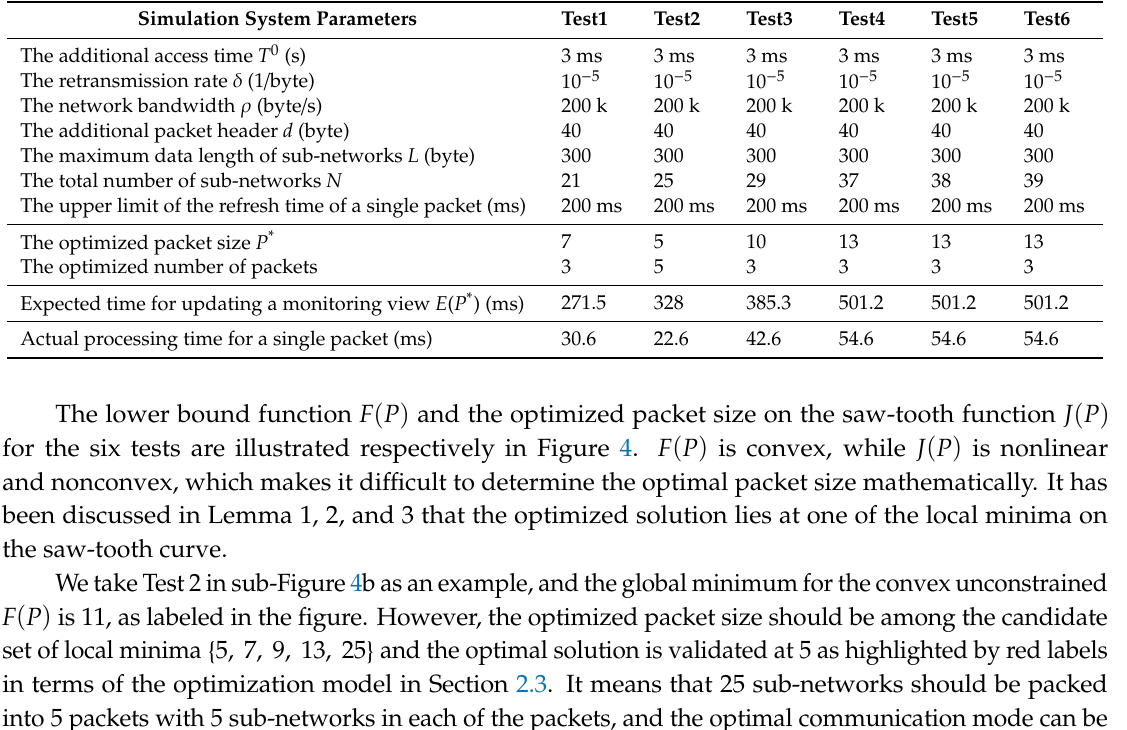
Table 1. Simulation results of optimized data packet-based